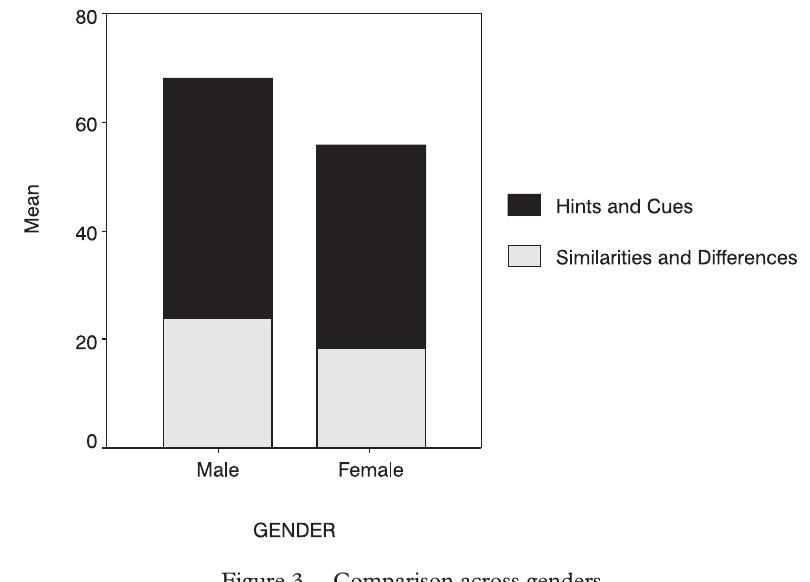
Figure 3. Comparison across